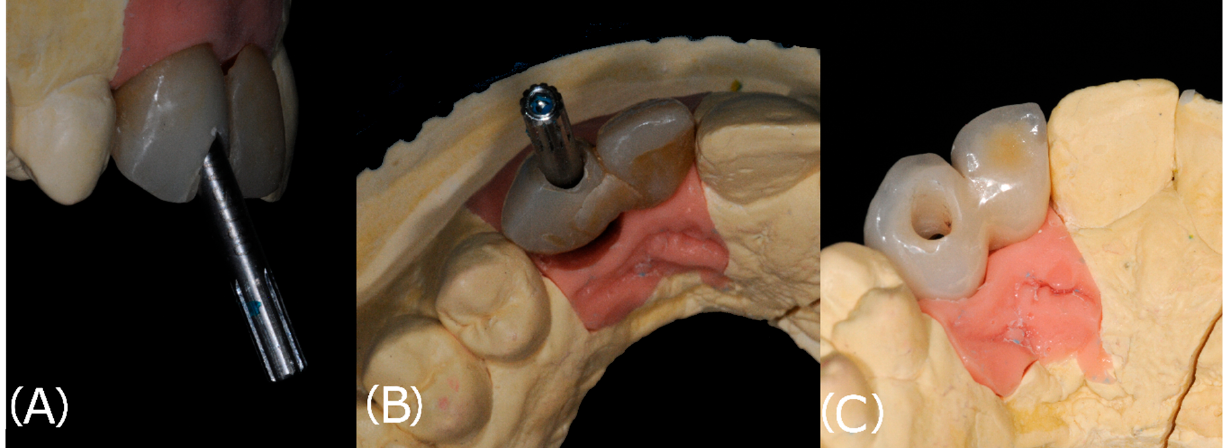
Figure 2. ( A ): The inclination of the implant fixture determined an unfavorable position of the access hole in the provisional restoration. ( B ): The access hole as seen from the occlusal surface. ( C ): Thanks to the application of ASCs in the definitive restoration, the access hole was moved to the palatal surface.